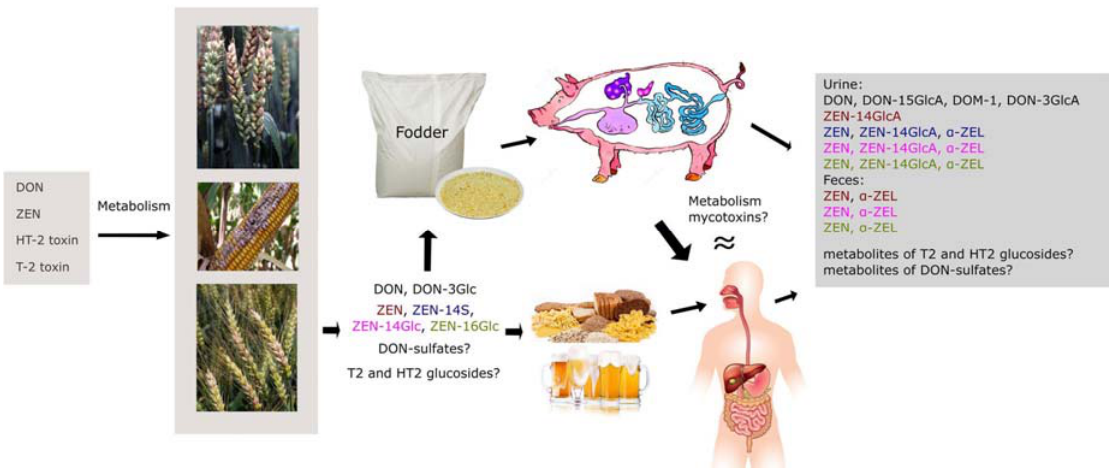
Figure 5. Mycotoxins and their modified forms in cereal plants and potential paths of their bio ‐ transformation in humans (compiled from literature data).